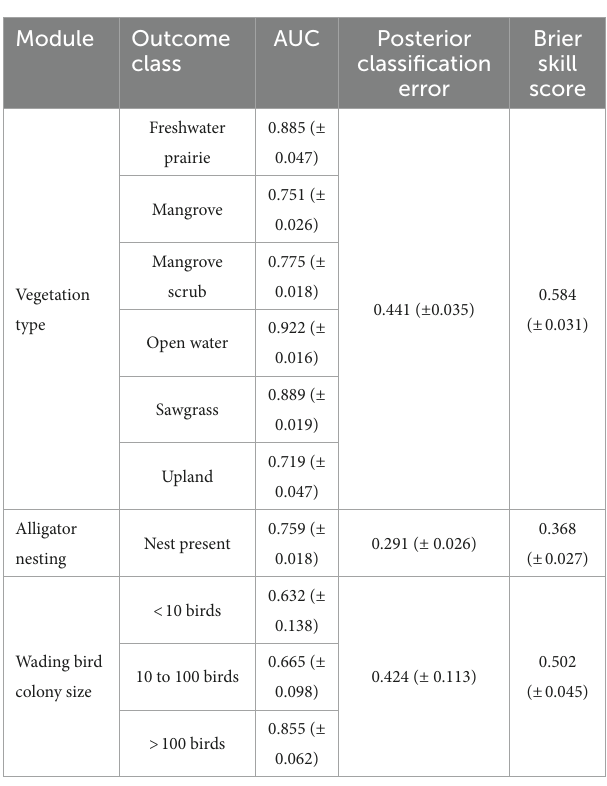
TABLE 3 Accuracy measures (AUC, posterior classification error, and Brier skill score) for three of the four Everglades vulnerability analysis (EVA)